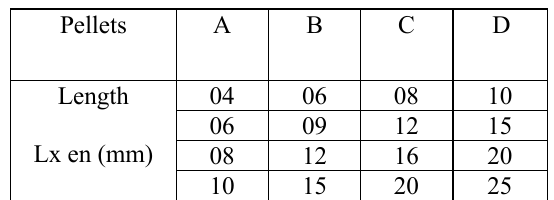
Table 4: The different values of